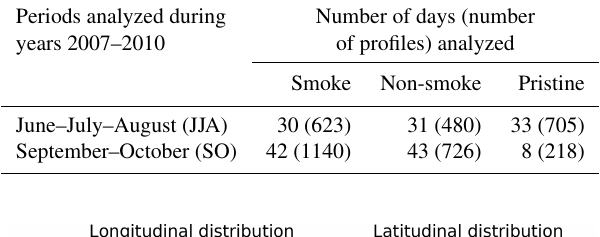
Table 2. Number of days and profiles used in the analysis for each case. The number of profiles in the smoke cases correspond to the elevated smoke shown in Fig. 1. In the non-smoke cases the number of profiles corresponds to the sum of the remaining aerosol types in Fig. 1. Details on the definition of the cases are found in Sect. 2.3. Periods analyzed during